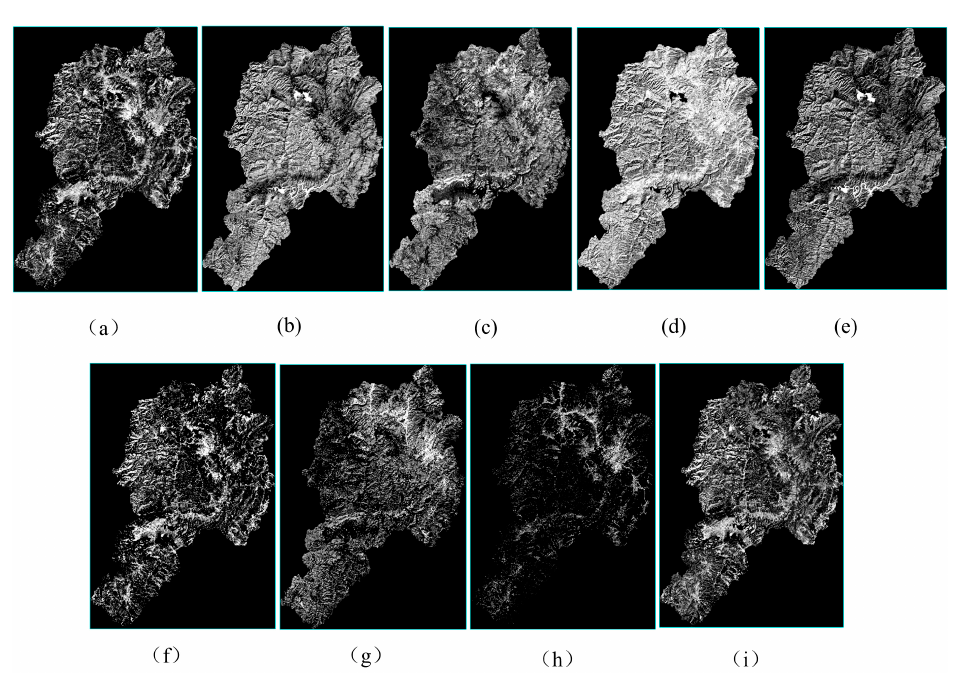
Figure 5. Endmember abundance maps of mixed pixel unmixing, ( a ) Grassland abundance, ( b ) Water abundance, ( c ) Arable land (including crops) abundance, ( d ) Arboreal forest abundance, ( e ) Low albedo abundance, ( f ) Arable land (no crops) abundance, ( g ) Desert and bare surface abundance, ( h ) High albedo abundance, and ( i ) Sparse shrub abundance. The range of abundance values is 0–1, and the brighter (values closer to 1) indicates the greater probability of approaching pure pixel.